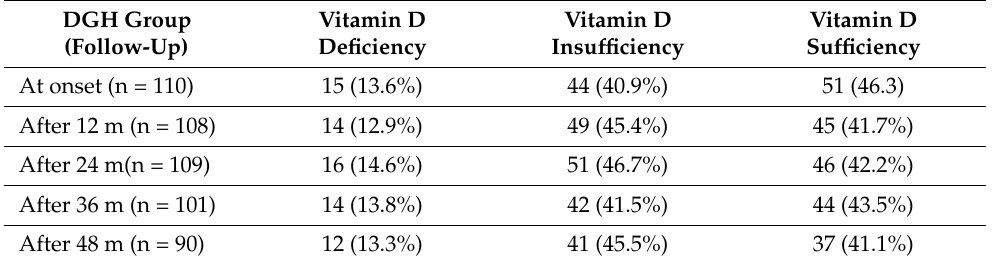
Table 4. Prevalence of calcidiol status in the different stages of follow-up in the GHD